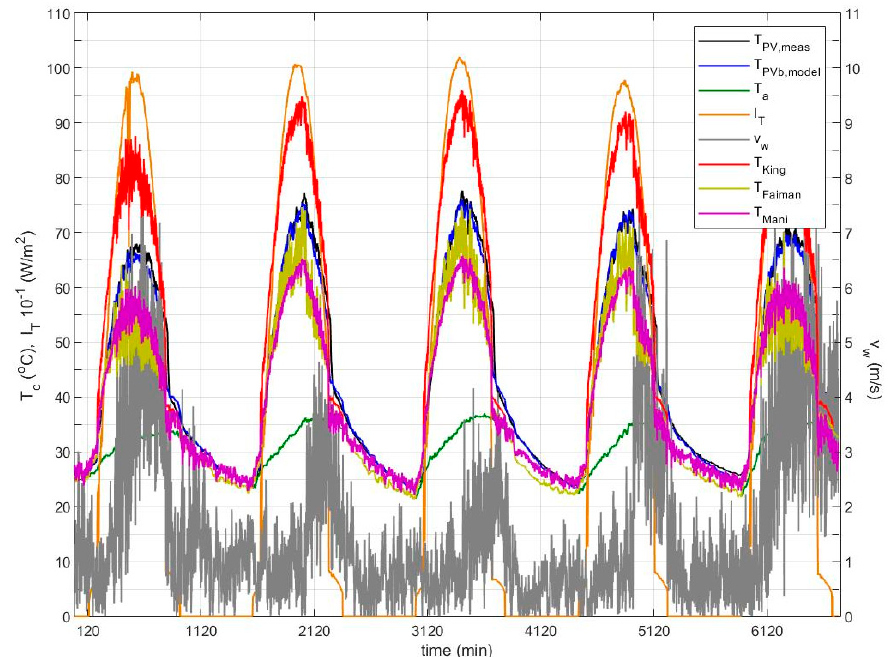
Figure 5. As in Figure 4, during 5 consecutive days in June, with interval 1 min.